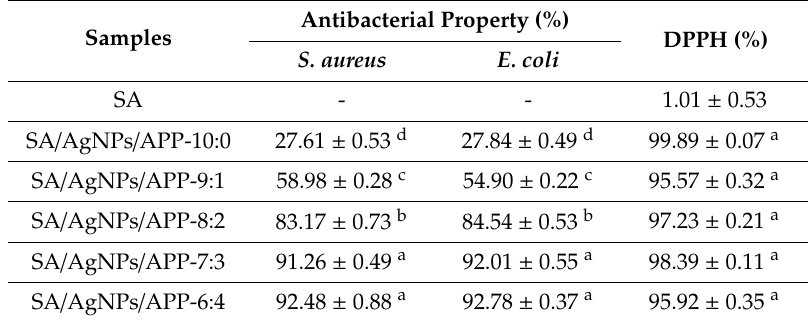
Table 3. Antimicrobial and antioxidant activities of the composite films. Antibacterial Property Samples